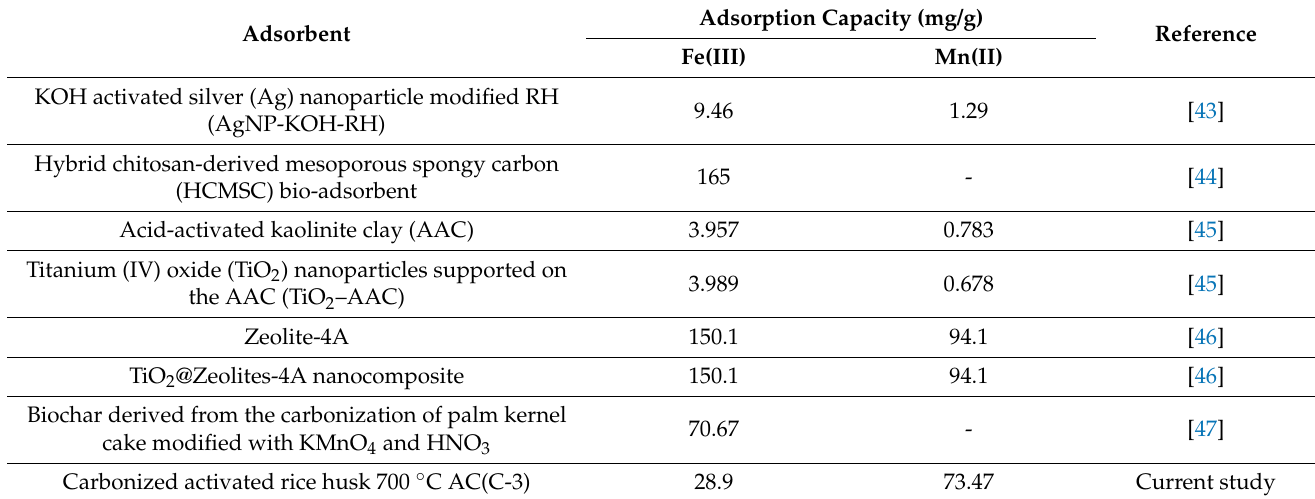
Table 14. A comparison between the adsorption capacities for CIP and LEV with other sorbents in previous